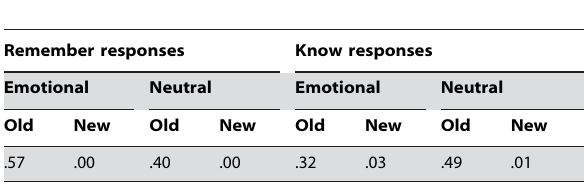
Table 1. Proportion of remember and know responses for old and new emotional and neutral